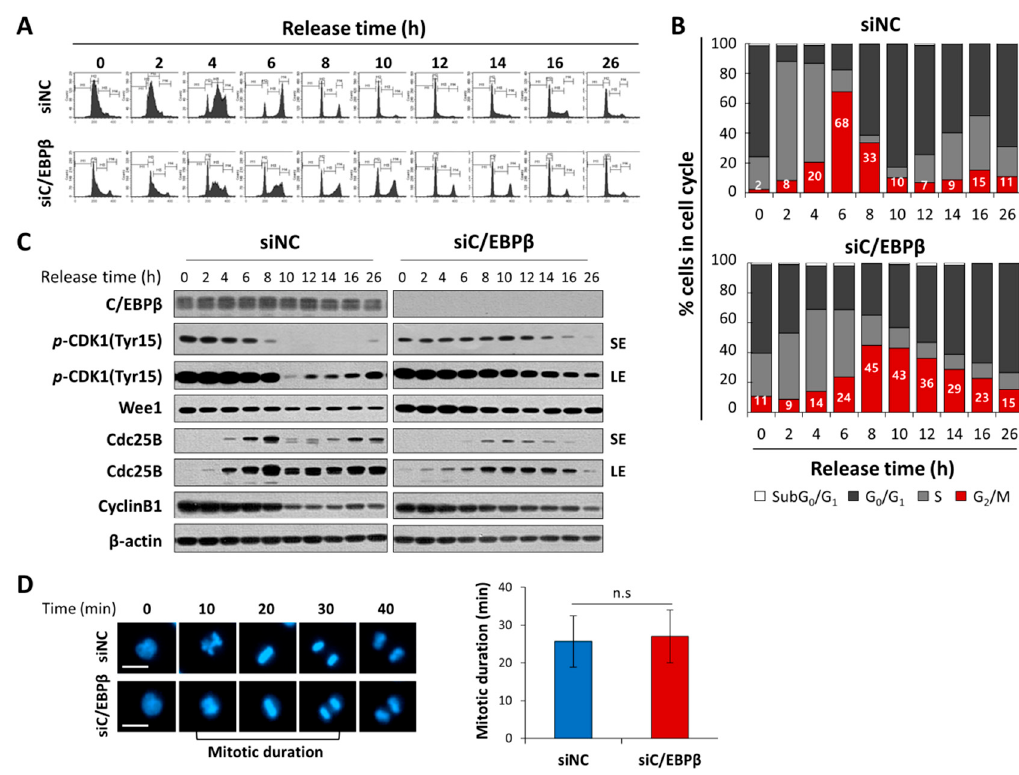
Figure 4. C/EBP β knockdown delays G 2 /M-cell cycle transition. ( A ) A time course study of the cell cycle analysis was performed in control or C/EBP β -knockdown A549 cells. Cells were released from thymidine double block-induced G 1 /S synchronization; and 0, 2, 4, 6, 8, 10, 12, 14, 16, and 26 h after releasing, cells were collected and stained with PI to measure DNA content using FACS. ( B ) The data are expressed as the percentage of cells in the subG 0 /G 1 , G 0 /G 1 , S, and G 2 /M phase at the indicated time points. ( C ) Whole cell lysates were prepared at the indicated times and Western blot analysis was performed for expression of proteins associated with the G 2 /M transition (Y15-pCDK1, Wee1, Cdc25B and Cyclin B1). SE; short exposure, LE; long exposure. ( D ) Mitotic duration of control or C/EBP β -knockdown A549 cells stained with NucBlue ® was monitored by an Operetta High Content Screening (HCS) System. Representative images of siNC and siC/EBP β -transfected cells from time lapse series were shown. Images were acquired every 10 min. Data are presented as mean ± SD of mitotic duration in 30 cells in each group. Mitotic duration was measured from nuclear envelope breakdown (prometaphase) to anaphase onsets [52]. Statistical significance was determined using the t -test; n.s., not significant. Cell images were taken at a magnification of 200X using an Operetta High Content Screening (HCS) System. Scale bar: 20 μ m.